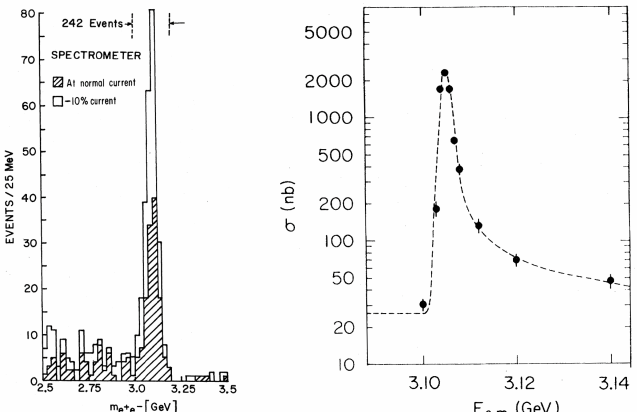
Figure 1. The experimental evidence for the J / ψ meson from the Alternating Gradient Synchrotron [1] at BNL ( left ) and the Stanford Positron Electron Asymmetric Rings at SLAC [2] ( right ). Reprinted with permission from American Physical Society.